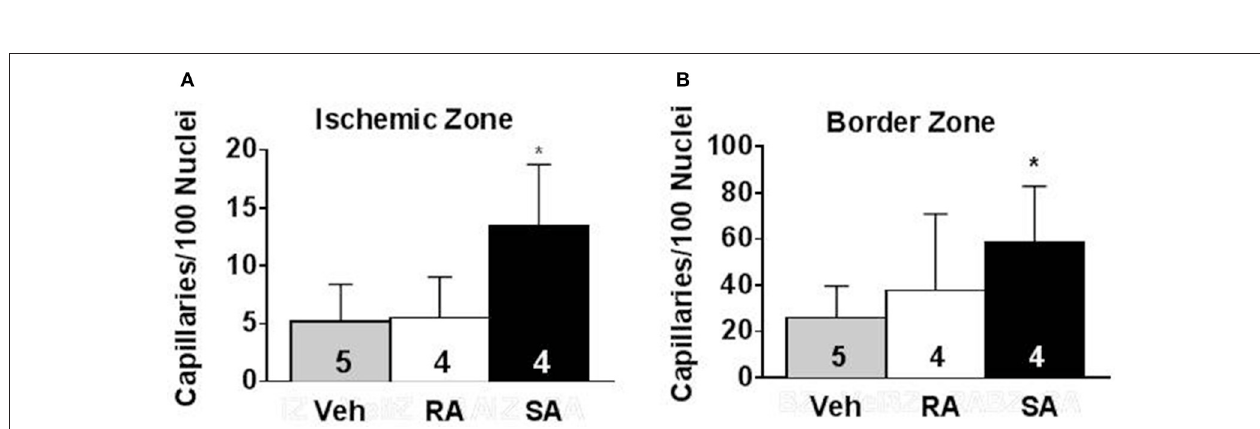
FIGURE 5 | Morphometric analysis. Representative Masson’s trichrome stained heart short axis sections from mice 35 days after injection of vehicle, RA, or SA c-kit pos CMCs (A) . Non-infarcted (i.e., Remote) and infarct wall thickness (B) , scar as percent of LV (C) and expansion index (D) . Values are mean ± SD. * p < 0.05 vs. vehicle.